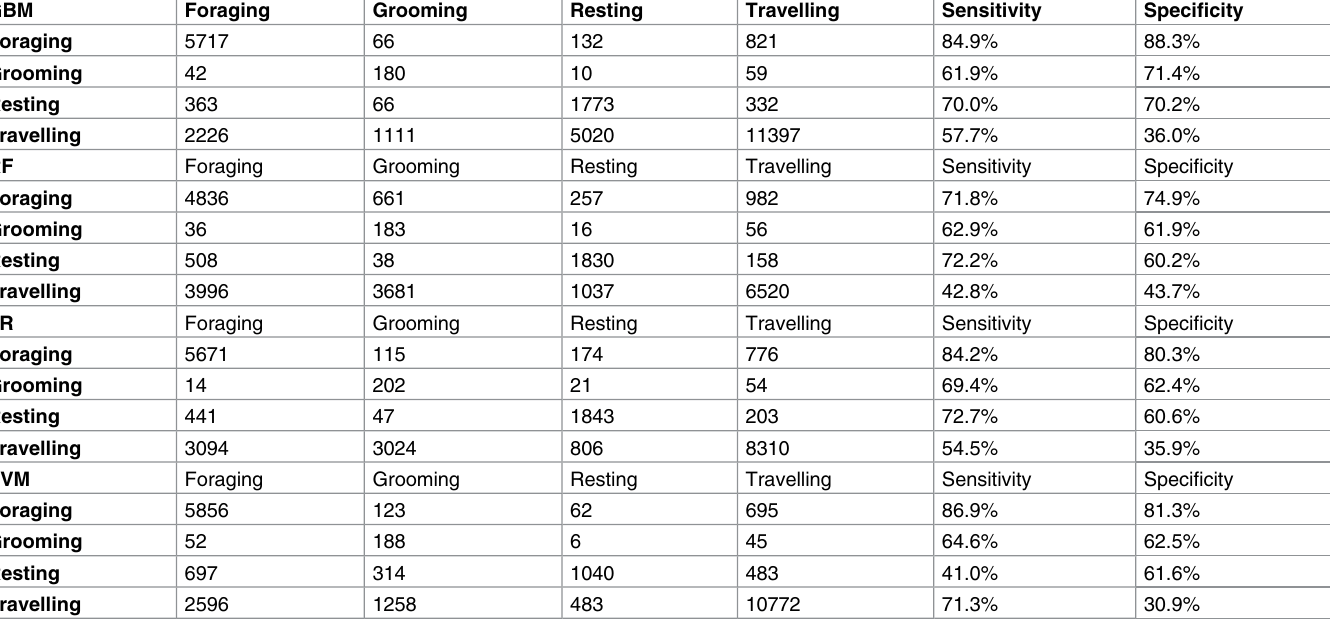
Table 4. Confusion matrix for the cross-validation results from the GBM, RF, LR and SVM models. ^Only the results from the best SVM (polynomial) are presentedhere.